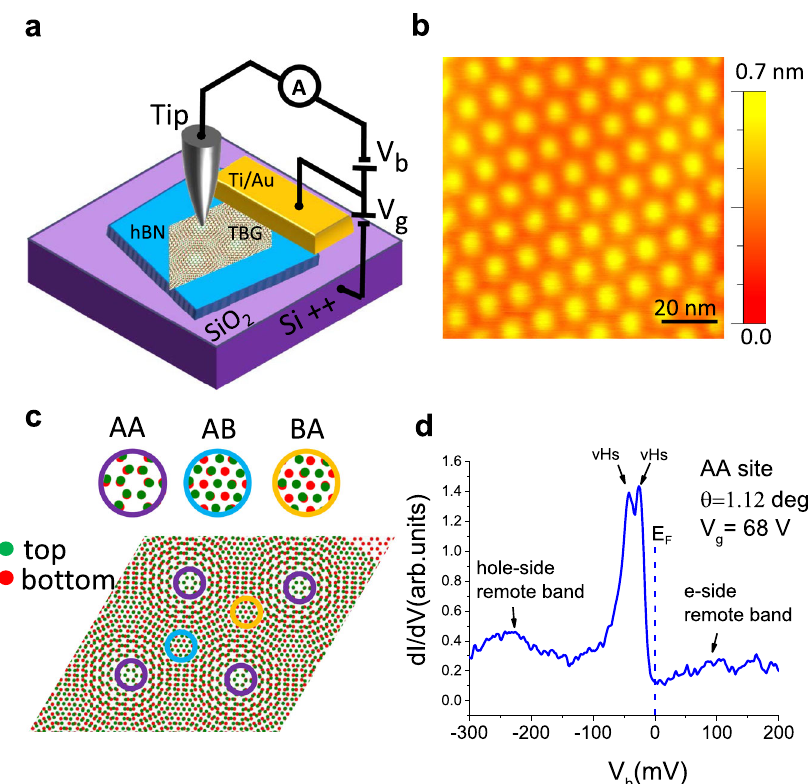
Fig. 1 STM/ STS on magic-angle twisted bilayer graphene. a Schematic of the STM device and measurement setup. The TBG sample was made using the “ twist and stack ” method. The Tungsten tip is kept grounded while a bias voltage V is applied to the sample. A backgate voltage V is applied between the b g p-doped silicon backgate and the sample. All measurements were taken at 4.9 K. b STM topography measured at a bias of − 300 mV and tunneling current of − 30 pA. The bright yellow spots which form a triangular lattice are the AA stacking regions. The surrounding darker orange regions have approximately AB and BA stacking. The moiré wavelength was measured from STM topography to be 12.6 nm which corresponds to a twist angle of 1.12°. c An illustration of the various stacking arrangements. The green and red dots represent the carbon atoms in the top and bottom Graphene layer respectively. d shows a typical dI = dV b spectrum measured at the center of an AA region at V g = 68 V when the fl at bands are completely full. The van Hove singularities (VHS) and the remote bands on either side of the fl at band are labeled. Gap-like dips in the dI = dV signal separate the fl at bands from the remote bands. The b Fermi level E F of sample is shown with a dashed line at V b ¼ 0